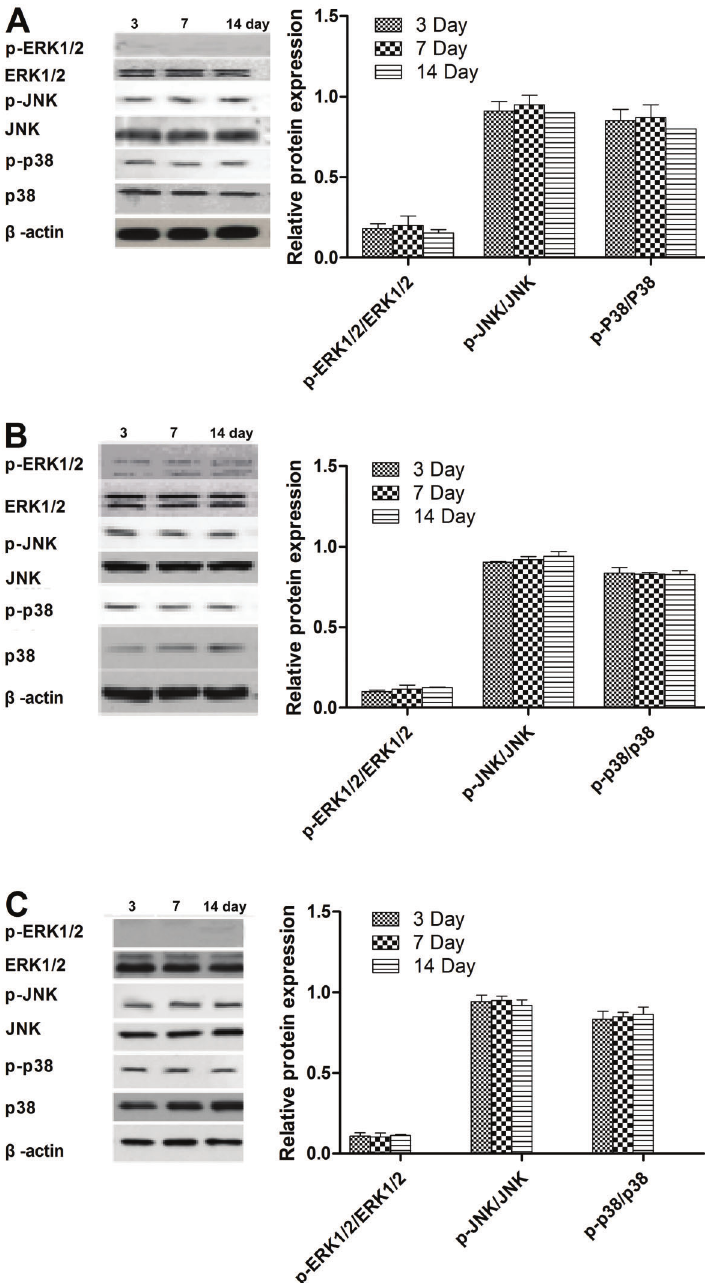
Figure 4. Effects of BMP-2/PELA ( A ) and PELA/ VEGF ( B ) scaffolds, as well as the positive con- trol ( C ), on the activation of mitogen-activated protein kinase (MAPK) signaling in rBMSCs cells. Results are reported as means ±